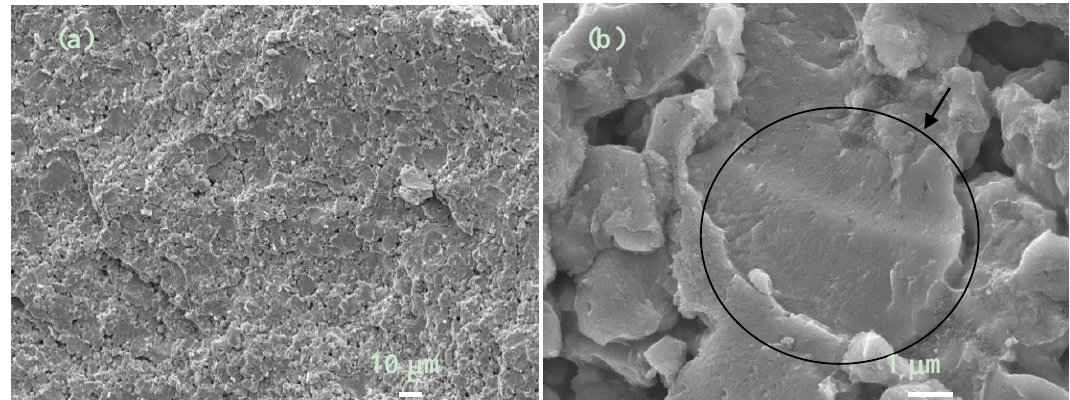
Figure 11. The fracture surface of Al 82 La 10 Fe 4 Ni 4 compact sintered at 573 K at different magnification of ( a ) 500 × and ( b ) 10,000 ×.